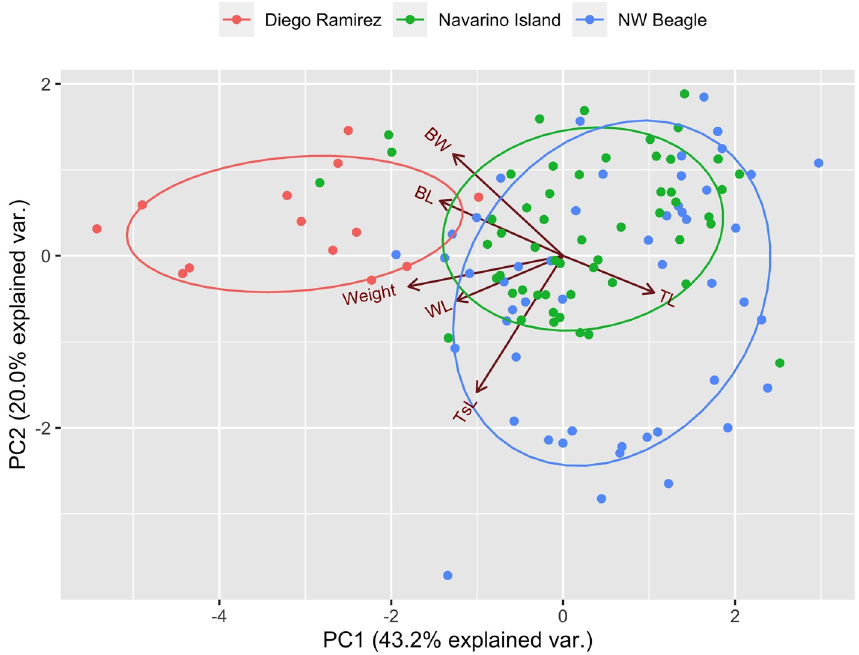
Figure 4. Principal component analysis of morphological variation of populations of thorn-tailed Rayadito ( Aphrastura spinicauda ) in the northwest arm of the Beagle Channel (blue) and Navarino Island (green), and for the population of the proposed new species A. subantarctica on Gonzalo Island, Diego Ramírez (red). Plotted are the first two components from a principal component analysis based on 117 measured individuals. WL wing length, TsL tarsus length, TL tail length, BL beak length, BW beak width, Weight body mass.